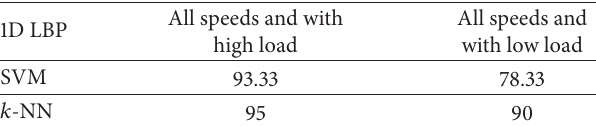
Table 14: Theperformanceof SVMinboth schemeswhen thecross- validation is LOLO and